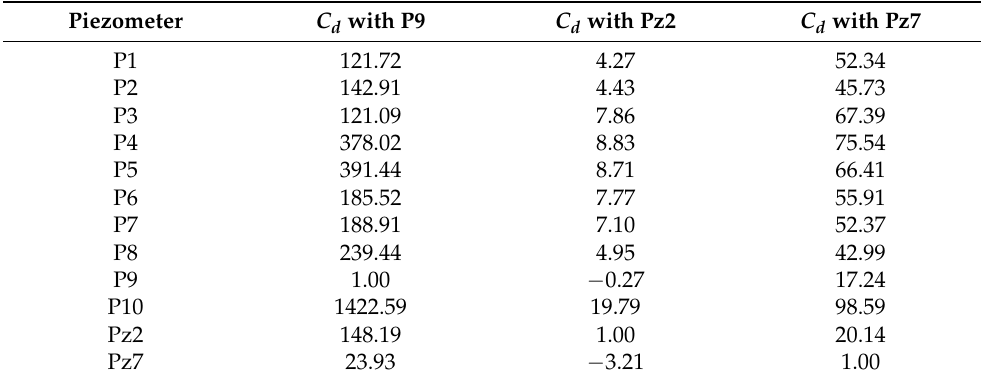
Table 3. Mean value of the contamination index with three different piezometers taken as the hydrochemical